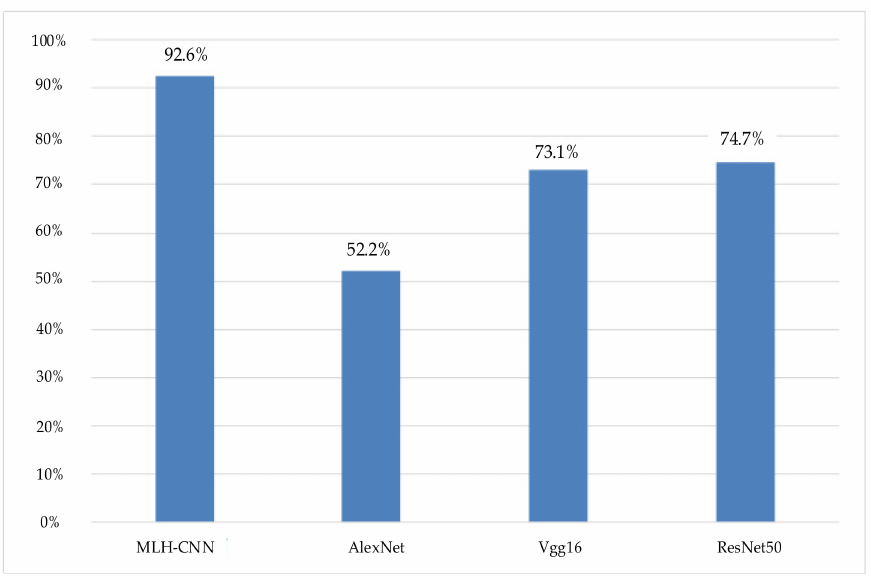
Figure 7. The classification accuracy of the four